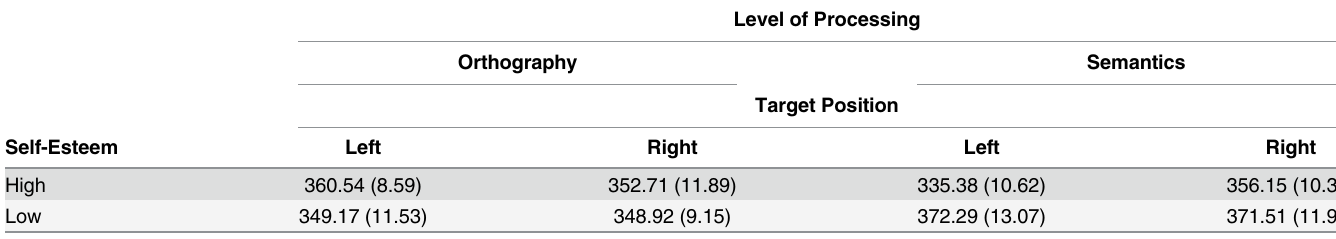
Table 2. Mean RTs to detect horizontally presented targets. Values in parantheses represent within-subjects